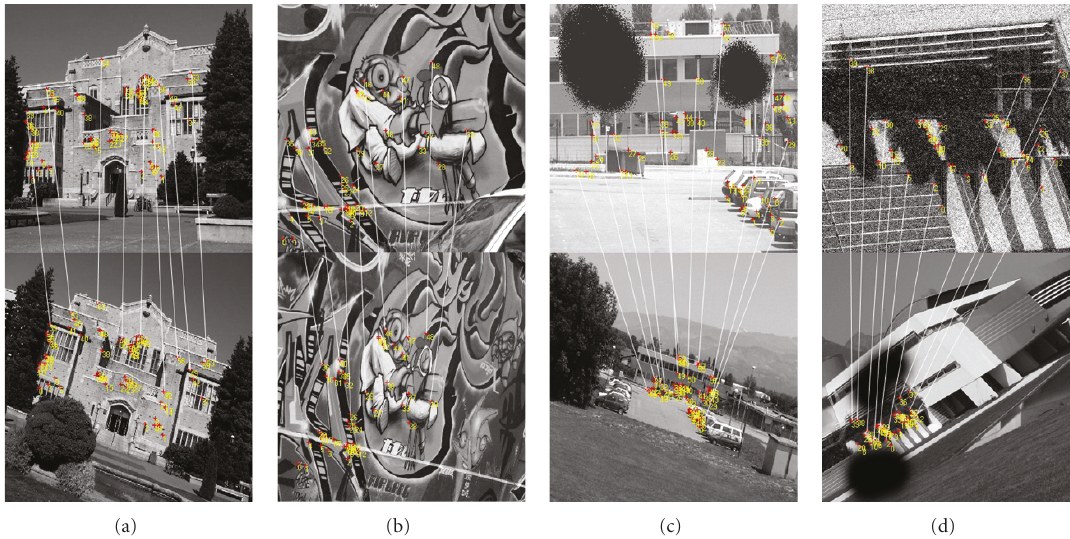
Figure 13: More matching results under viewpoint changes and other imaging conditions. (a) Matching result for image pair Gra ffi ti (frames 1 and 3 of “Gra ff 6” sequence). The viewpoint angle is 30 degrees, and there are 49 matches, all of them are correct. (b) Matching result for image pair UBC (frames 8 and 10 of “UBC v” sequence). The viewpoint angle is 30 degrees, and there are 65 matches with 1 false match. (c) Matching result for image pair East park (frames 1 and 7 of “East park” sequence). The scale factor is 3.3, and the rotation angle is 16 degrees. Occlusion and illumination changes are also added. There are 59 matches, all of them are correct. (d) Matching result for image pair Inria (frames 0 and 7 of “Inria” sequence). The scale factor is 3.4, and the rotation angle is 25 degrees. Occlusion and Gaussian noise are also added. There are 40 matches, all of them are correct.